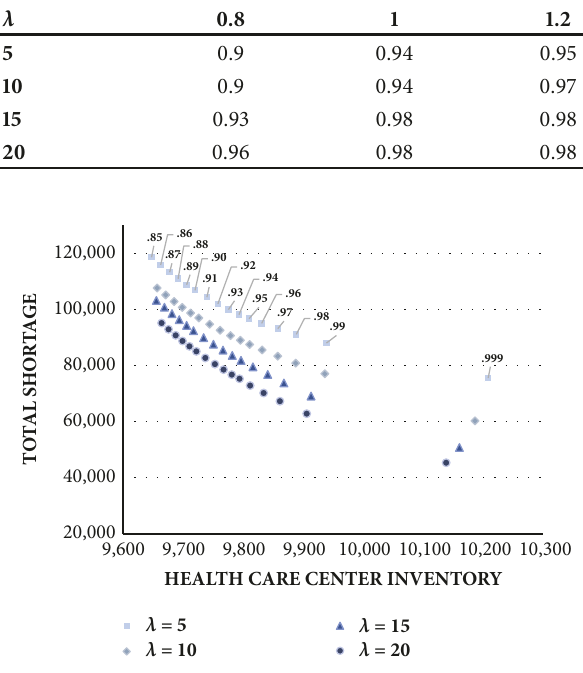
Figure 4: For different recall patterns, defined by 𝜆 , the resulting total shortage and health care centerinventory for various inventory policies, defined by the